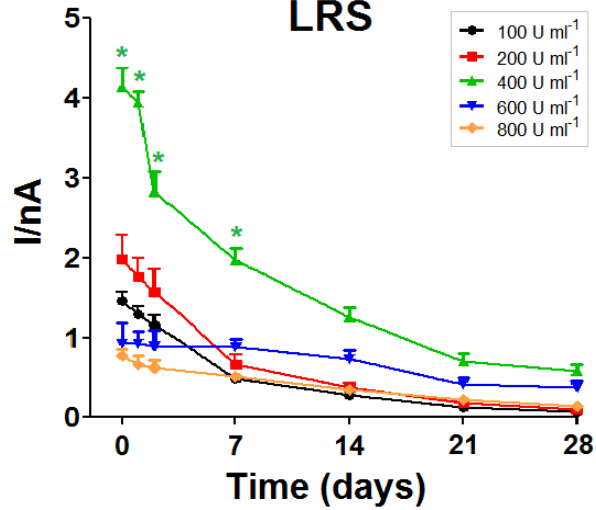
Figure 3. In-vitro stability study: evolution of the LRS over a 28-day monitoring period for biosensors fabricated from different enzyme loading solutions ( n = 4 for each group). * p < 0.05 vs. other